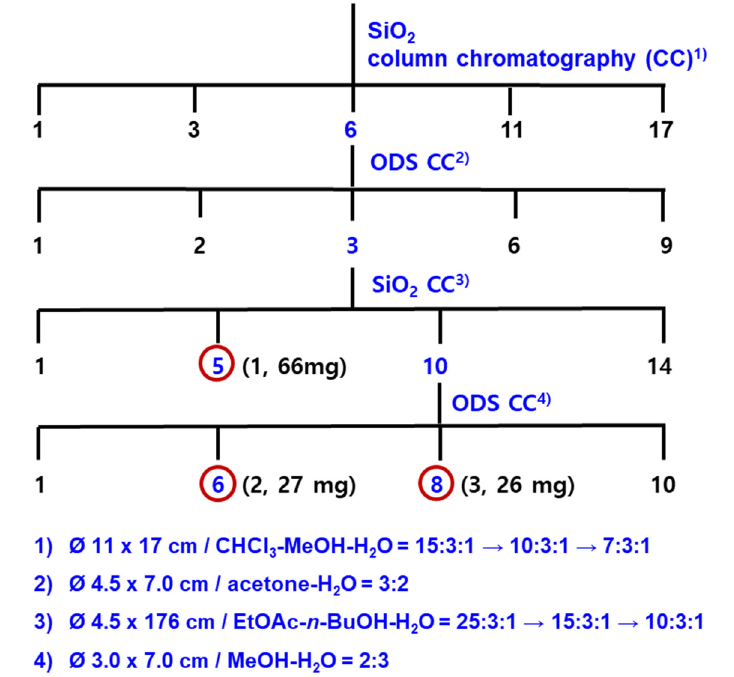
Figure 4. Isolation of phthalide glycosides from the n -BuOH fraction of Cnidium officinale rhizomes. Ligusticoside C (1) White powder; TLC (SiO 2 ) Rf 0.28, EtOAc- n -BuOH-H 2 O (15:3:1), (ODS) Rf 0.31, MeOH–H 2 O (2:3); [ α ] D − 7.0 (c 0.01, CH 3 OH); IR (LiF plates) ν max 3367, 2928, 1742,